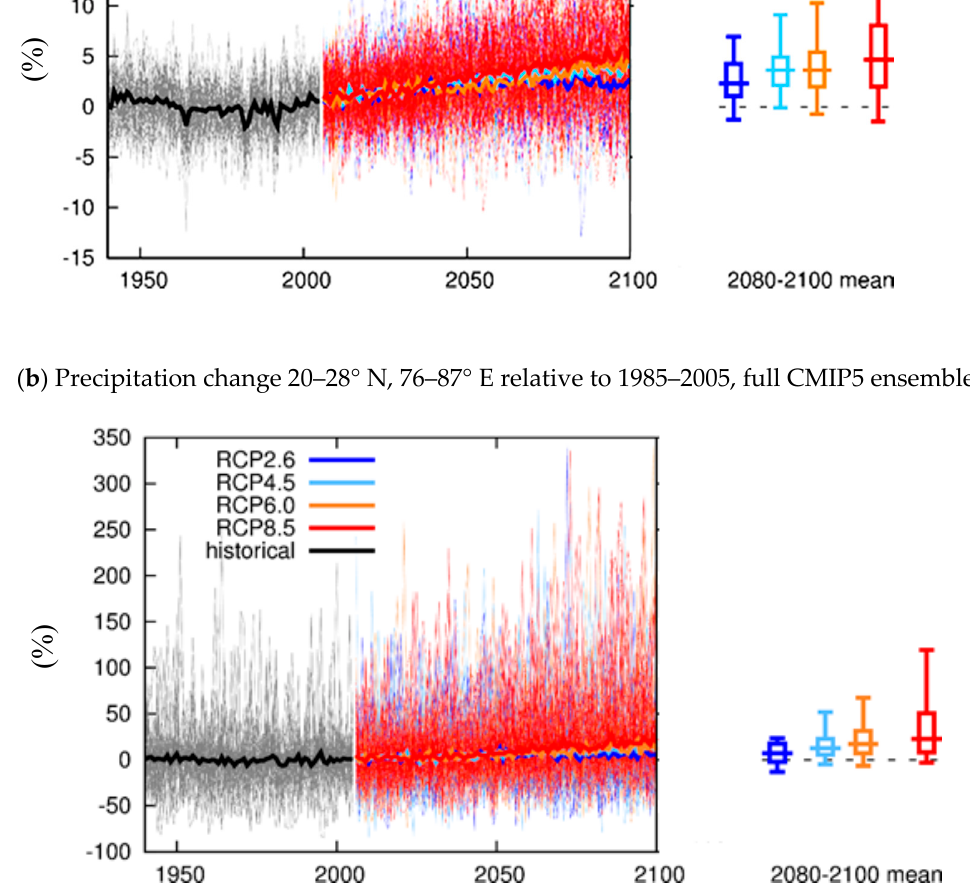
Figure 7. The cumulative rainfall (JJAS) for the world, the land region ( a ) and the region CI of India ( b ) over the 21st and part of 20th centuries, as simulated by climate models (generated using the IPCC’s Climate Change Atlas; climexp.knmi.nl/plot _atlas_form.py). The ensemble mean and spread associated with various RCP scenarios (over the 2080–2100 period) are shown at the right.